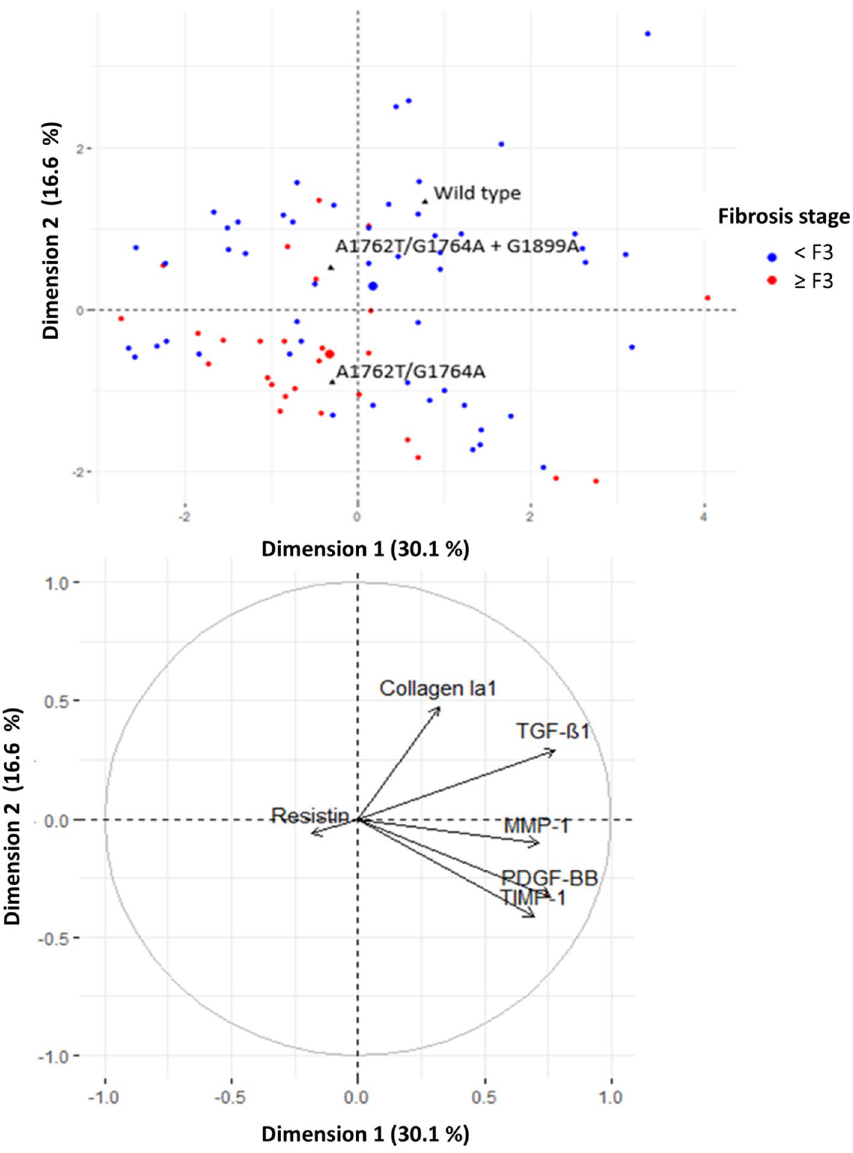
Figure 3. Factor Analysis of Mixed Data (FAMD) (categorical data [top] and continuous data [bottom]). Individuals with nonsevere fibrosis are plotted in blue, and individuals with advanced fibrosis are plotted in red. The largest blue (red) point shows the average location of individuals with nonsevere (advanced) fibrosis. The black triangles indicate the average location of individuals according to their mutation profile. Individuals with similar profiles are close to each other in the figure. For each continuous variable, the arrow provides a measure of the proportion of variance captured by a particular dimension. For example, dimension 1 captured approximately 75% of the variability of TGF-B1 and